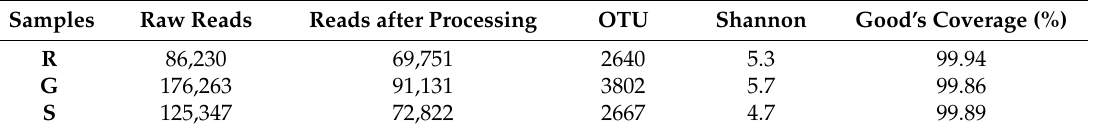
Table 1. Summary of 16S rDNA sequencing and analysis of Sopradeira cave samples. R (rock), G (gravel-like), and S